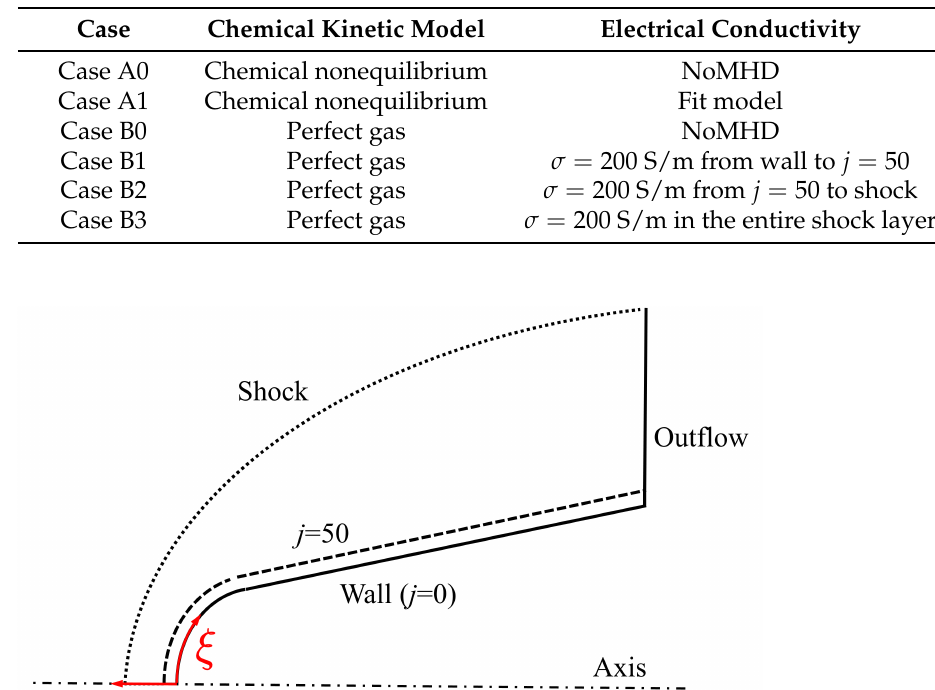
Table 2. Cases set-up.